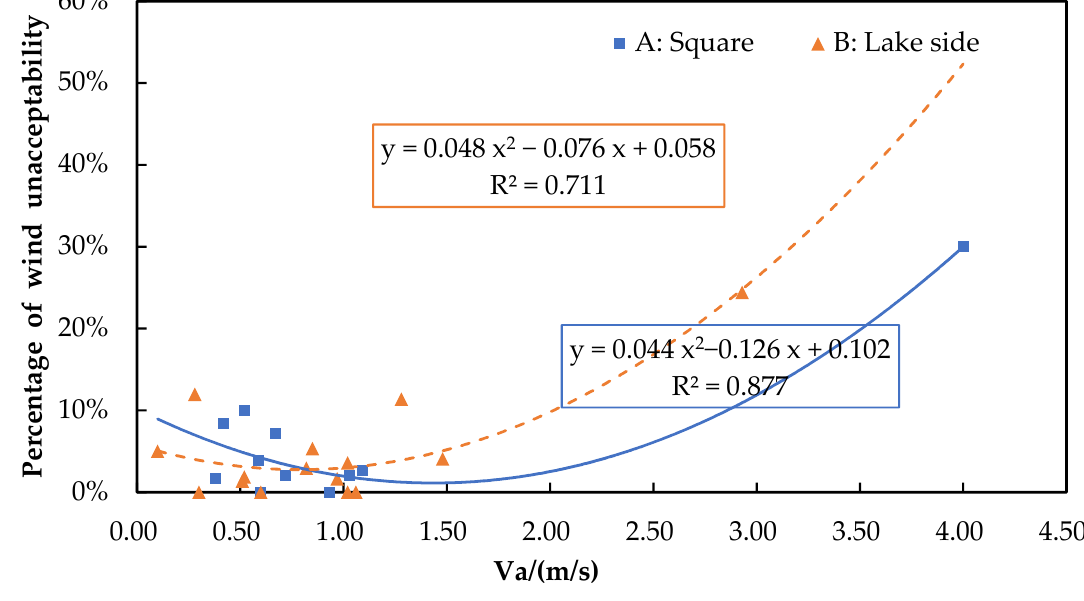
Figure 8. Percentage of wind unacceptability and wind speed.